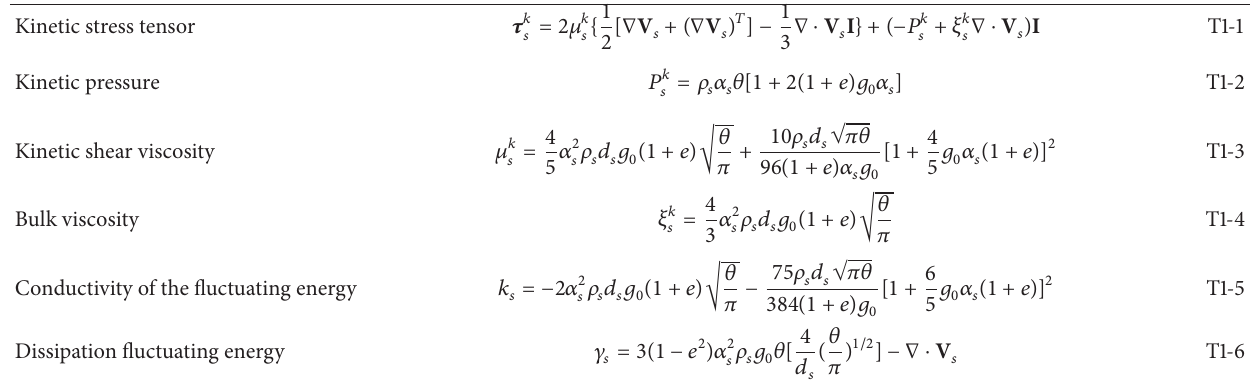
Table 1: Kinetic constitutive